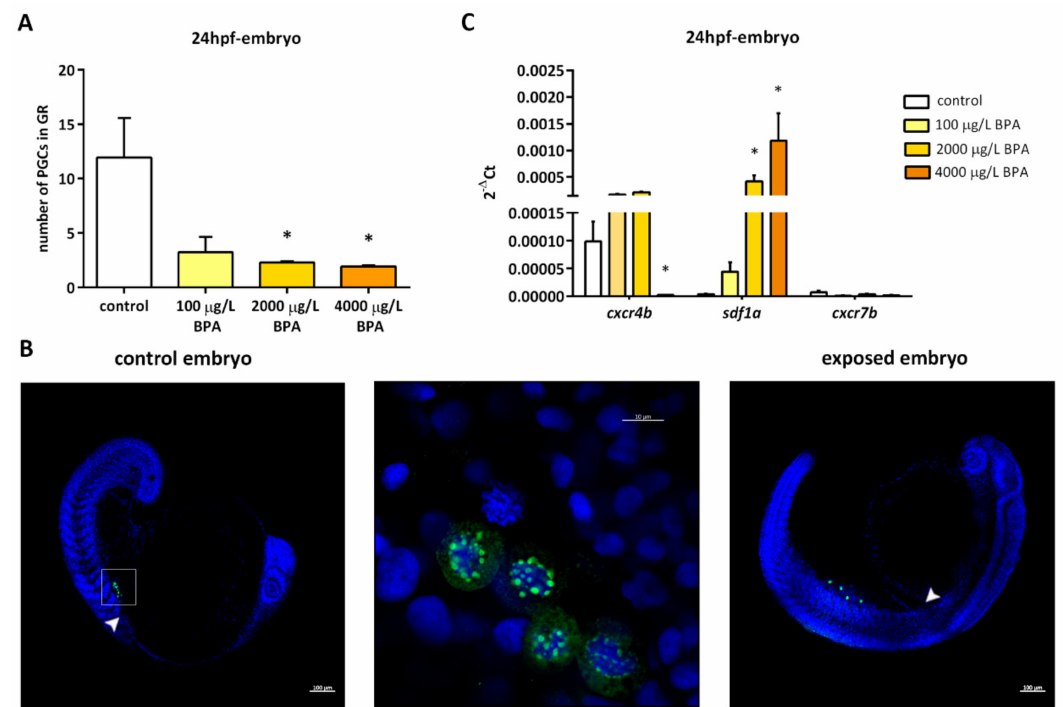
Figure 1. ( A ) Number of primordial germ cells (PGCs) observed in the genital ridge of embryos at 24 h post fertilization (hpf). Bars represent mean of PGCs in 5 embryos at 24 hpf in 3 di ff erent experiments ( n = 3). Asterisks indicate significant di ff erences ( p < 0.05) when compared to control groups. ( B ) Location of PGCs (green fluorescence) by confocal imaging in 24 hpf embryos. In control embryos (left picture), they were located within the genital ridge (arrowhead); scale bar 100 µ m. The inset region is enlarged in the middle picture, in which germ cells are marked with Vasa (green spots surrounding nuclear area stained with DAPI); scale bar 10 µ m. In 24 hpf embryos exposed to 4000 µ g / L BPA (right picture), PGCs appeared outside the genital ridge (arrowhead); scale bar 100 µ m. ( C ) Relative expression of genes involved in primordial germ cell migration in the genital ridges of control and BPA-exposed embryos. Expression levels relative to 18 S rRNA were calculated using 2 − ∆ Ct method in three independent experiments ( n = 3). Asterisks indicate significant di ff erences ( p < 0.05) when compared to control